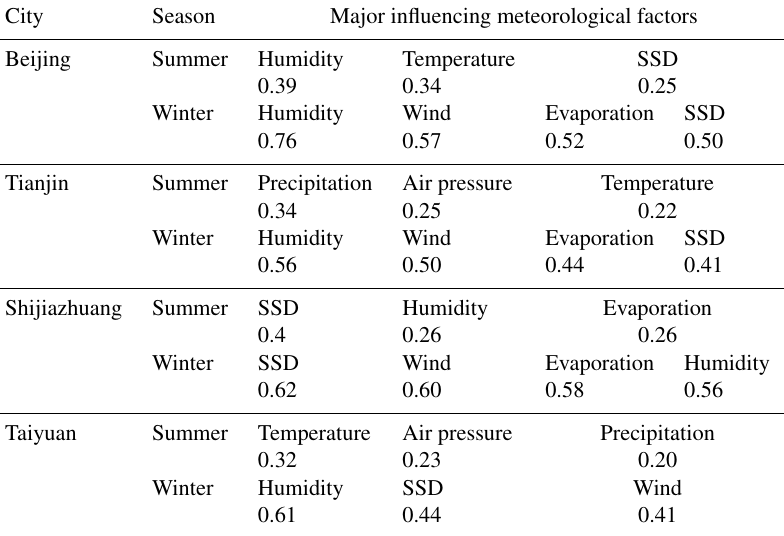
Table 2. Summer and winter major influencing meteorological factors for PM 2 . 5 concentrations in four major cities in the North China region. City Season Major influencing meteorological factors